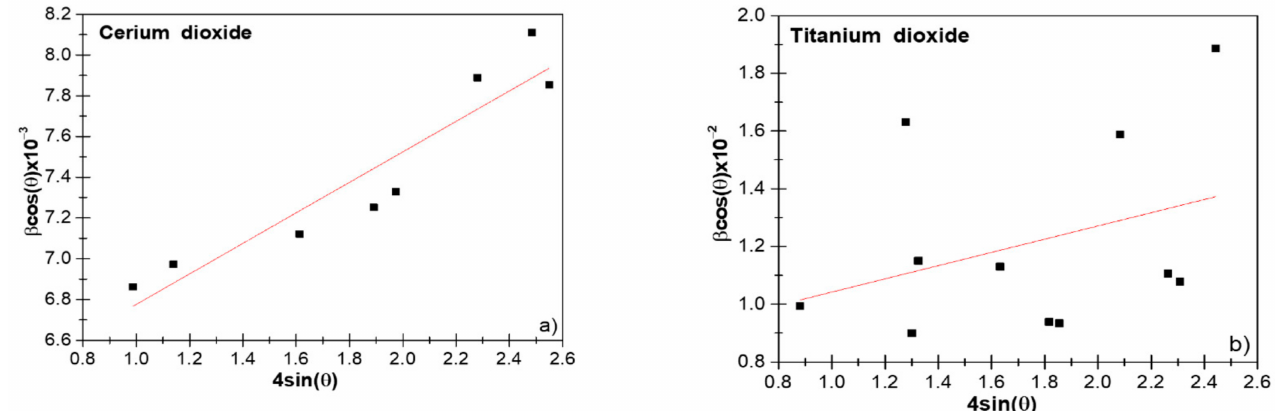
Figure 2. The Williamson–Hall (W–H) analysis of CeO 2 ( a ) and TiO 2 ( b ) nanoparticles (NPs), assuming uniform deformation model